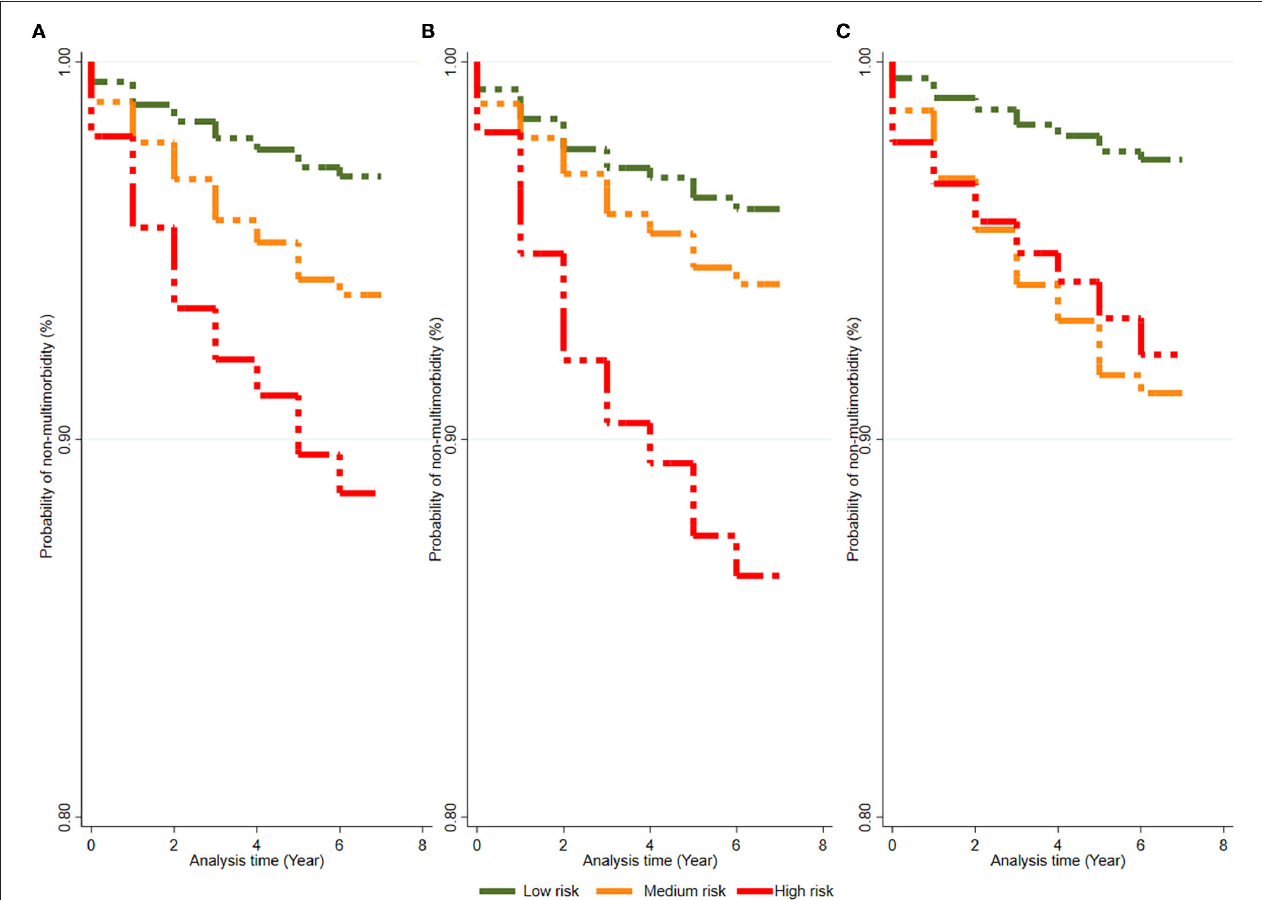
FIGURE 1 | The change of probability without multimorbidity of people in seven-year-follow-up. (A–C) Represent the probability of non-multimorbidity in total population, males and females, respectively.